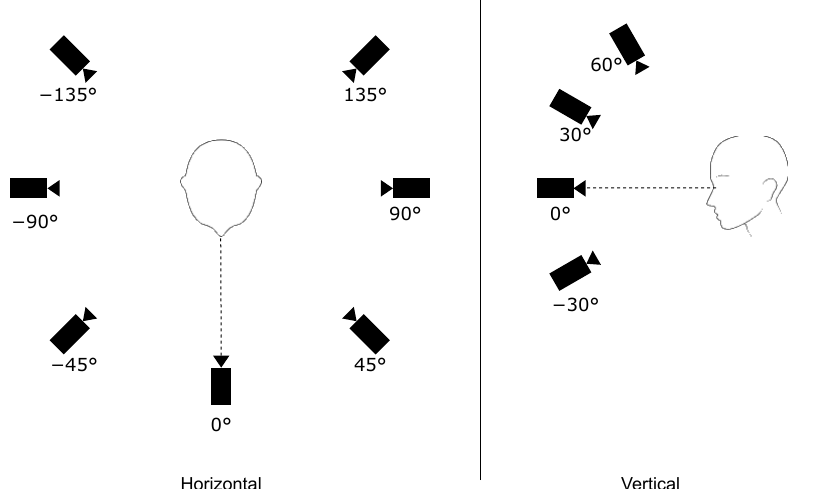
Figure 2. The different points of view for the acquisition of the FRMDB mugshots on the horizontal plane ( left ) and the vertical plane ( right ).